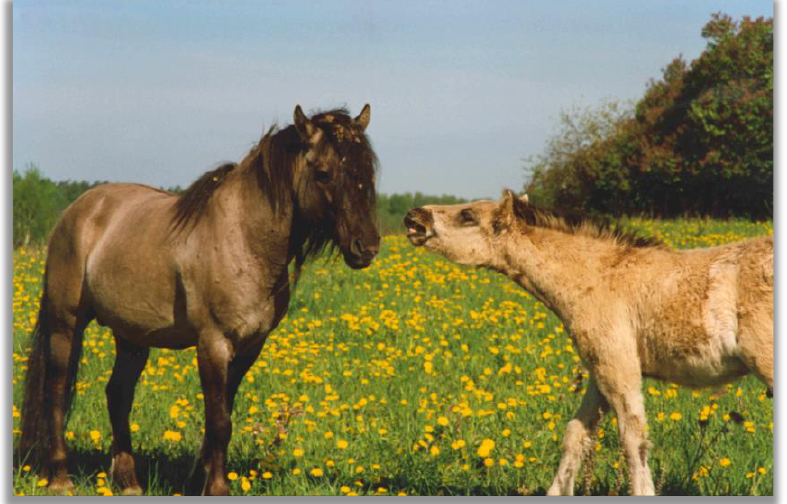
Figure 5. “Snapping” foal approaching a Konik stallion, Zielony Ostrów sanctuary, Poland (photo by Tadeusz Jezierski).